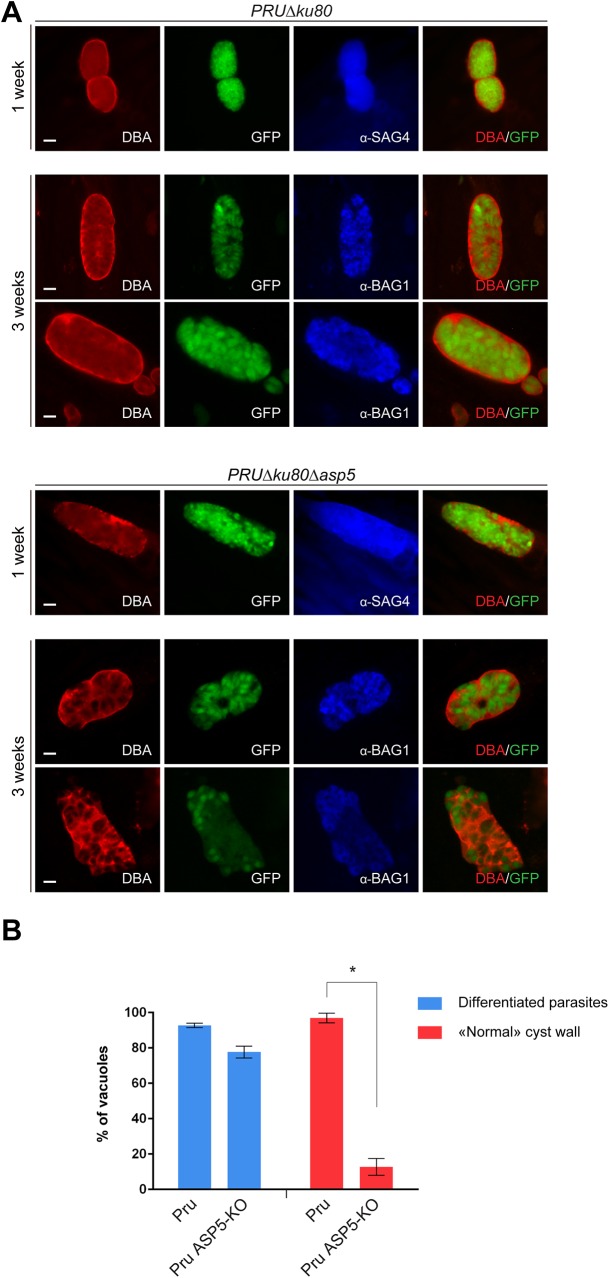
Cyst wall formation is affected in type II parasites lacking ASP5.(A) Induced bradyzoite differentiation of type II parasites under high pH conditions. In parasites lacking ASP5, cyst wall formation, as visualized with DBA lectin, was already affected 1 week after induced-differentiation. α-SAG4 (surface antigen 4) and α-BAG1 (bradyzoite antigen 1) were used as bradyzoite markers. GFP is under the control of a bradyzoite lactate dehydrogenase 2 (LDH2) promoter. Scale bars represent 2 μm. (B) Quantification of the representative IFAs depicted in panel (A). Data are mean value ± s.d. of three independent experiments.